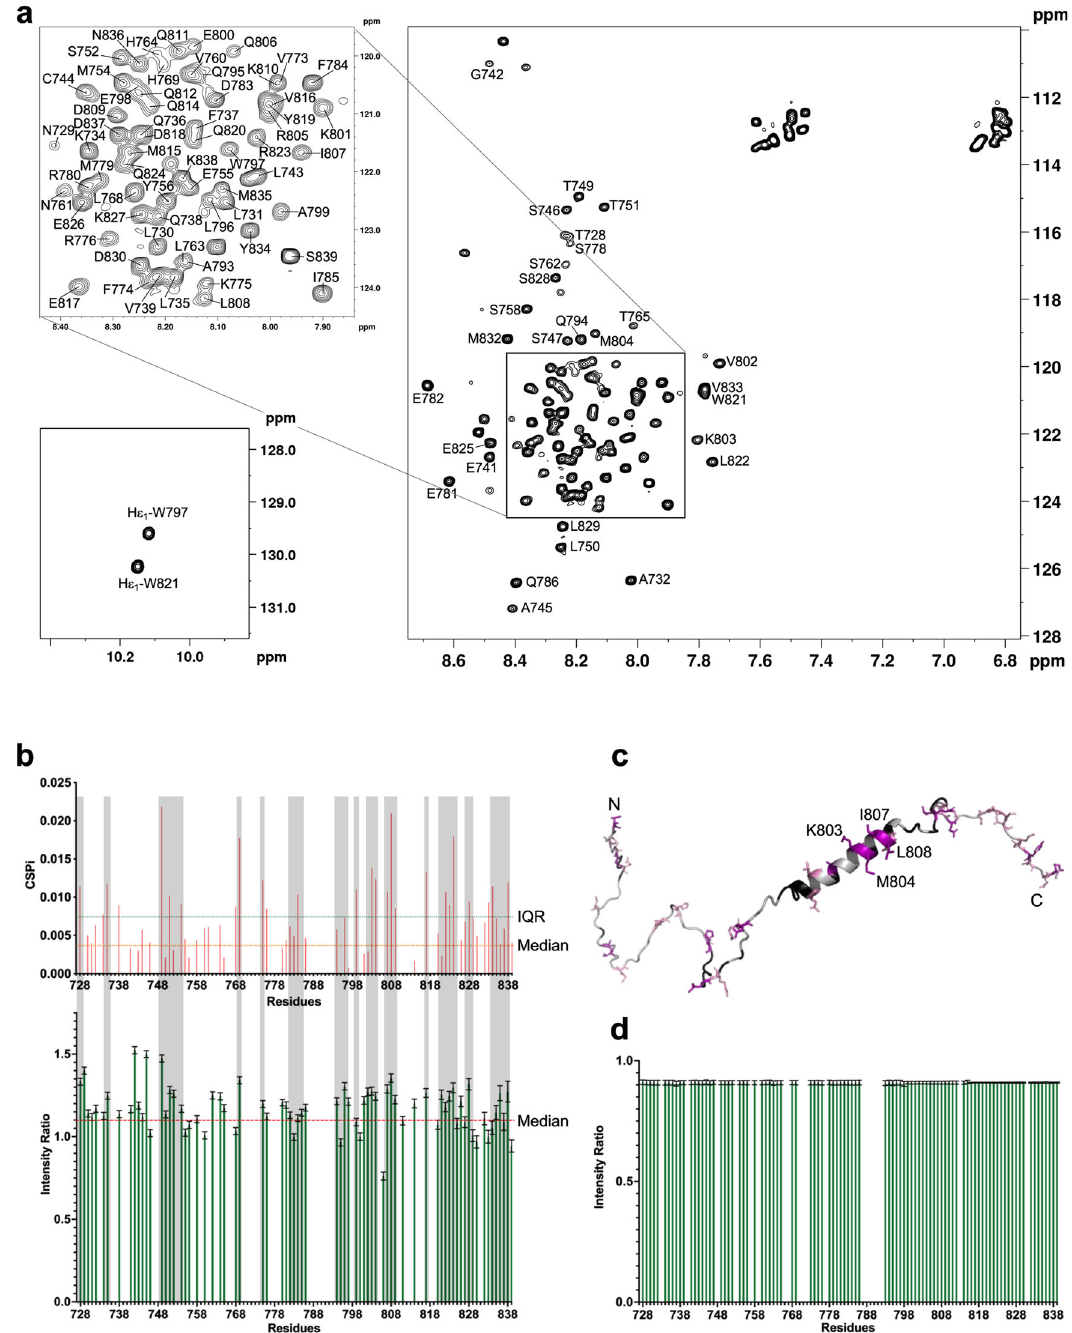
Fig. 4 Structural characterisation of PYK2 KFL728-839 by NMR. a [ 1 H- 15 N] HSQC spectrum of PYK2 KFL 728 – 839 recorded on a Bruker Avance III 950 MHz spectrometer at 25 °C, pH 6.5, on a 250 µ M 15 N-uniformly labelled sample. Cross-peak assignments are indicated using the one-letter amino acid and number code. The central part of the spectrum is expanded in the insert at the top left. Assignment of tryptophan indole NH proton resonances is represented at the bottom left. b ( Top ) CSP occurring as a result of diluting [ 13 C, 15 N] PYK2 KFL 728-839 from 100 µ M (8 scans) to 10 µ M (128 scans), monitored by 2D [ 1 H- 15 N] HSQC. The orange horizontal line indicates the median threshold for minor shifts and the horizontal green line and shows the interquartile range (IQR) threshold for major shifts. ( Bottom ) Plot of 2D [ 1 H- 15 N] HSQC intensity ratios of [ 13 C, 15 N] PYK2 KFL 728-839 . The ratios were calculated as 10 µ M (128 scans) divided by 100 µ M (8 scans). The intensity value at 100 µ M was taken as a reference and used to normalise the intensity value at 10 µ M to compensate for an overall loss of intensity upon dilution. Red dotted line indicates the median. Grey-shaded zones indicate residue regions where signi fi cant CSPs correspond to regions of lower relative intensity ( c ) CSPs from b were mapped on a representative 3D structure of PYK2 KFL 728 – 839 . Major shifts are marked in magenta, minor shifts are coloured in pink and prolines, overlapping and unassigned residues are marked in black. N and C indicate the N-terminal and C-terminal of the molecule. d Plot of 2D [ 1 H- 15 N] HSQC intensity ratios of [ 1H , 15 N] PYK2 KFL 728-839 . The ratios were calculated as 100 µ M (8 scans) measured on 700 MHz divided by 100 µ M (8 scans) measured on 950